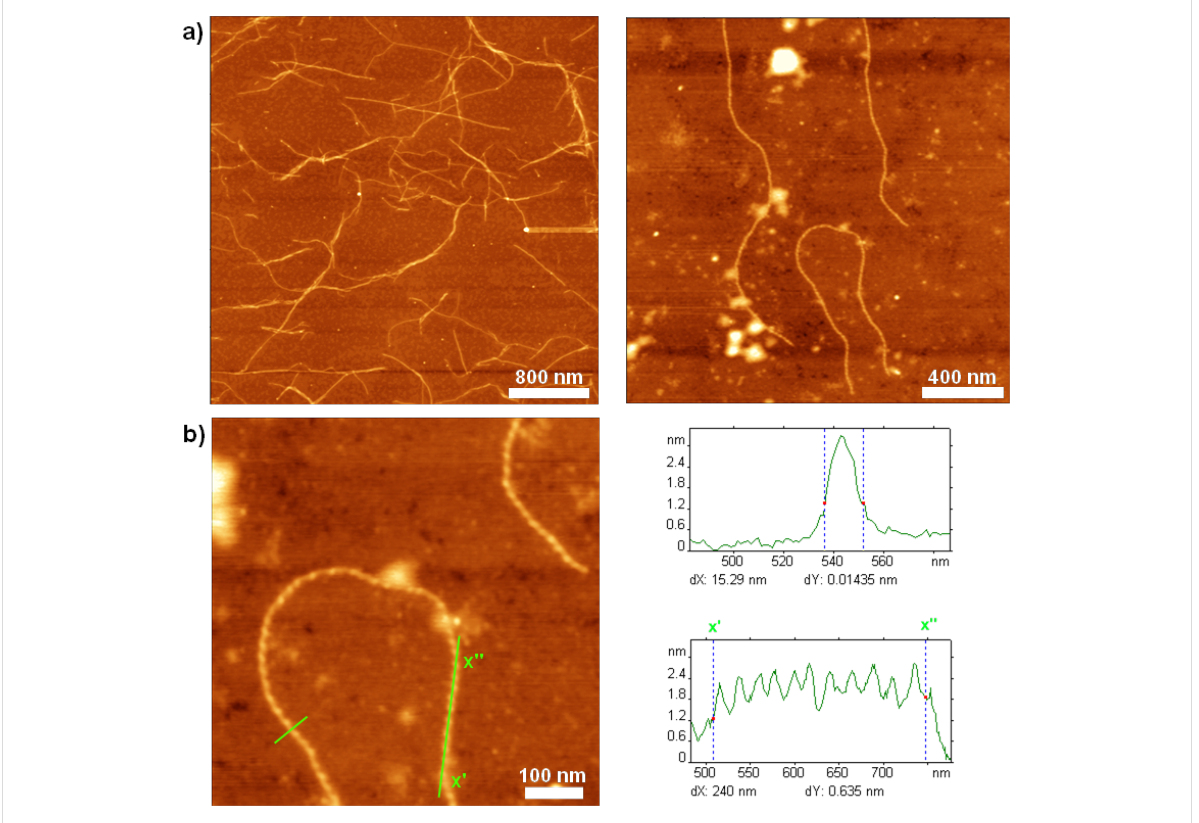
Figure 3: AFM height images of hybrid 1' on mica from a 1:1 DCM/MeOH solution; a) left: Network of fibers after 2 d; right: Fibrillar features found after 2 h; b) left: Left-handed helical fiber, right: Cross section and height profile from the marked sections in 2b [22].